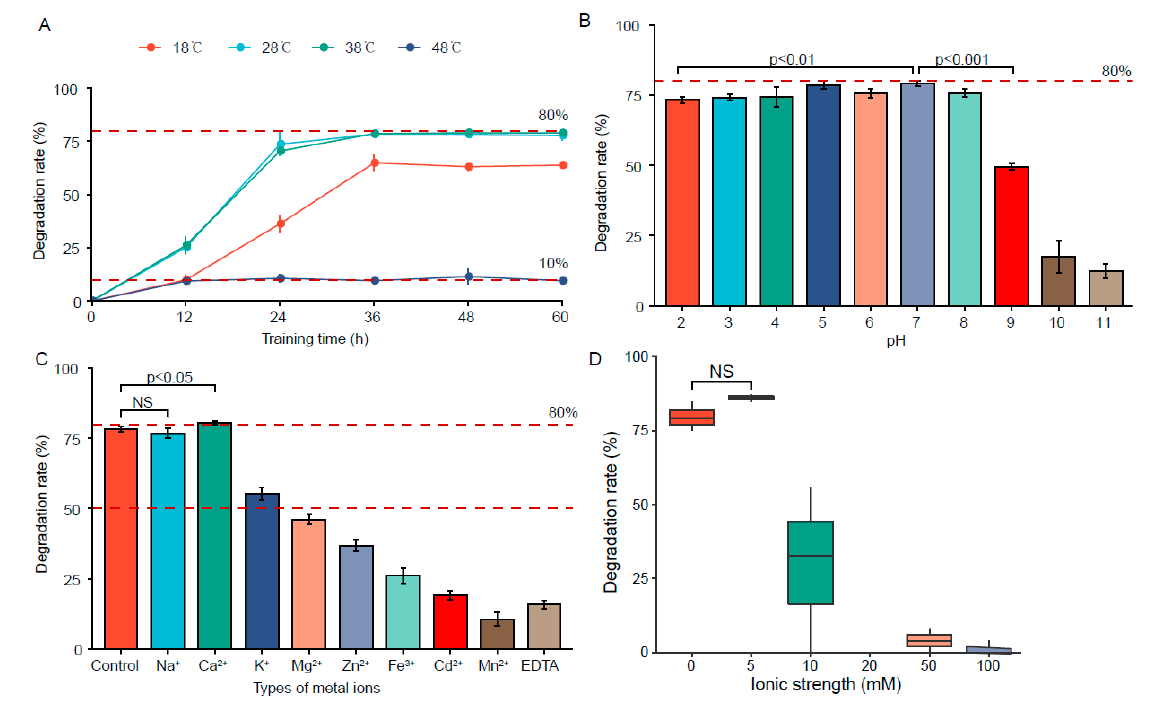
Figure 3. Optimal degradation conditions of FSZ: ( A ) temperature; ( B ) pH; ( C ) metal ions; ( D ) ionic strength.